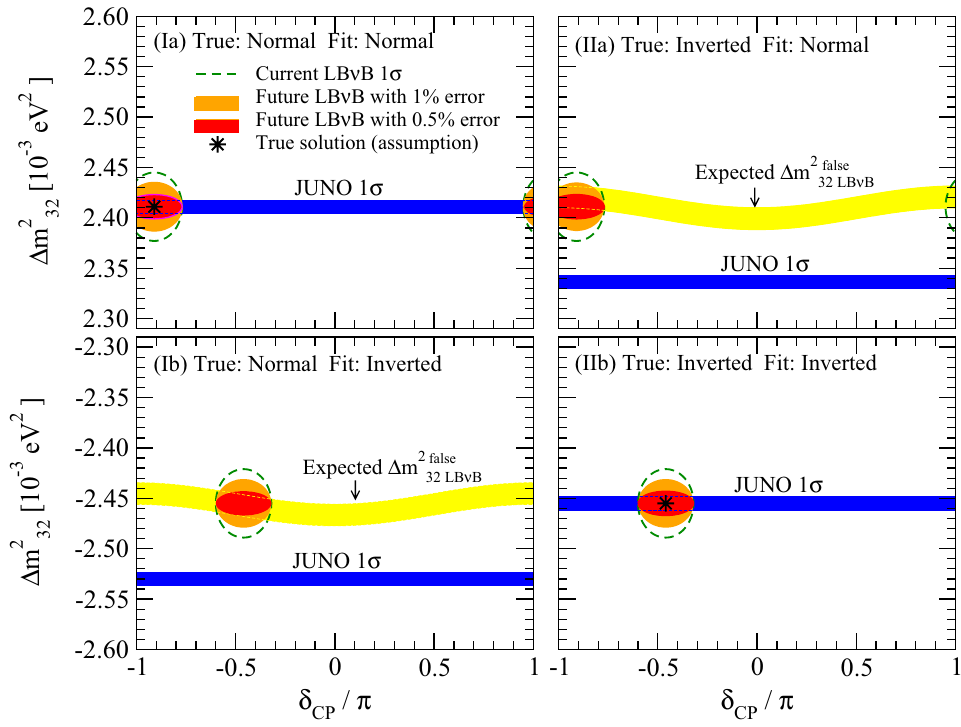
Figure 3. Origin of MO Boosting by LB ν B for JUNO. Semi-quantitative and schematic illustration of the LB ν B JUNO MO resolution synergy is shown for the cases where the true MO is normal (left panels) or inverted (right panels). For each case, the true values of (cid:31) m 2 32 are assumed to coincide with the NuFit5.0 best fitted values indicated by the black asterisk symbols. For each assumed true value of (cid:31) m 2 32 , possible range of the false values of (cid:31) m 2 32 to be determined from LB ν B DC is indicated by the yellow color bands where their width reflects the ambiguity due to the CP phase (see Appendix C). The approximate current 1 σ allowed ranges of ( δ CP , � m 2 32 ) from NuFit5.0 are indicated by the dashed green curve whereas the future projections assuming the current central values with 1% (0.5%) uncertainty of (cid:31) m 2 32 are indicated by filled orange (red) color. Expected 1 σ ranges of (cid:31) m 2 32 from JUNO alone are indicated by the blue color bands though the ones in the wrong MO region would be disfavored at ∼ 3 σ confidence level (CL) by JUNO itself. When the MO which is assumed in the fit coincides with the true one, allowed region of (cid:31) m 2 32 by LB ν B overlaps with the one to be determined by JUNO as shown in the panels I(a) and II(b). On the other hand, when the assumed (true) MO and fitted one do not coincide, the expected (false) values of (cid:31) m 2 32 by LB ν B and JUNO do not agree, as shown in the panels I(b)